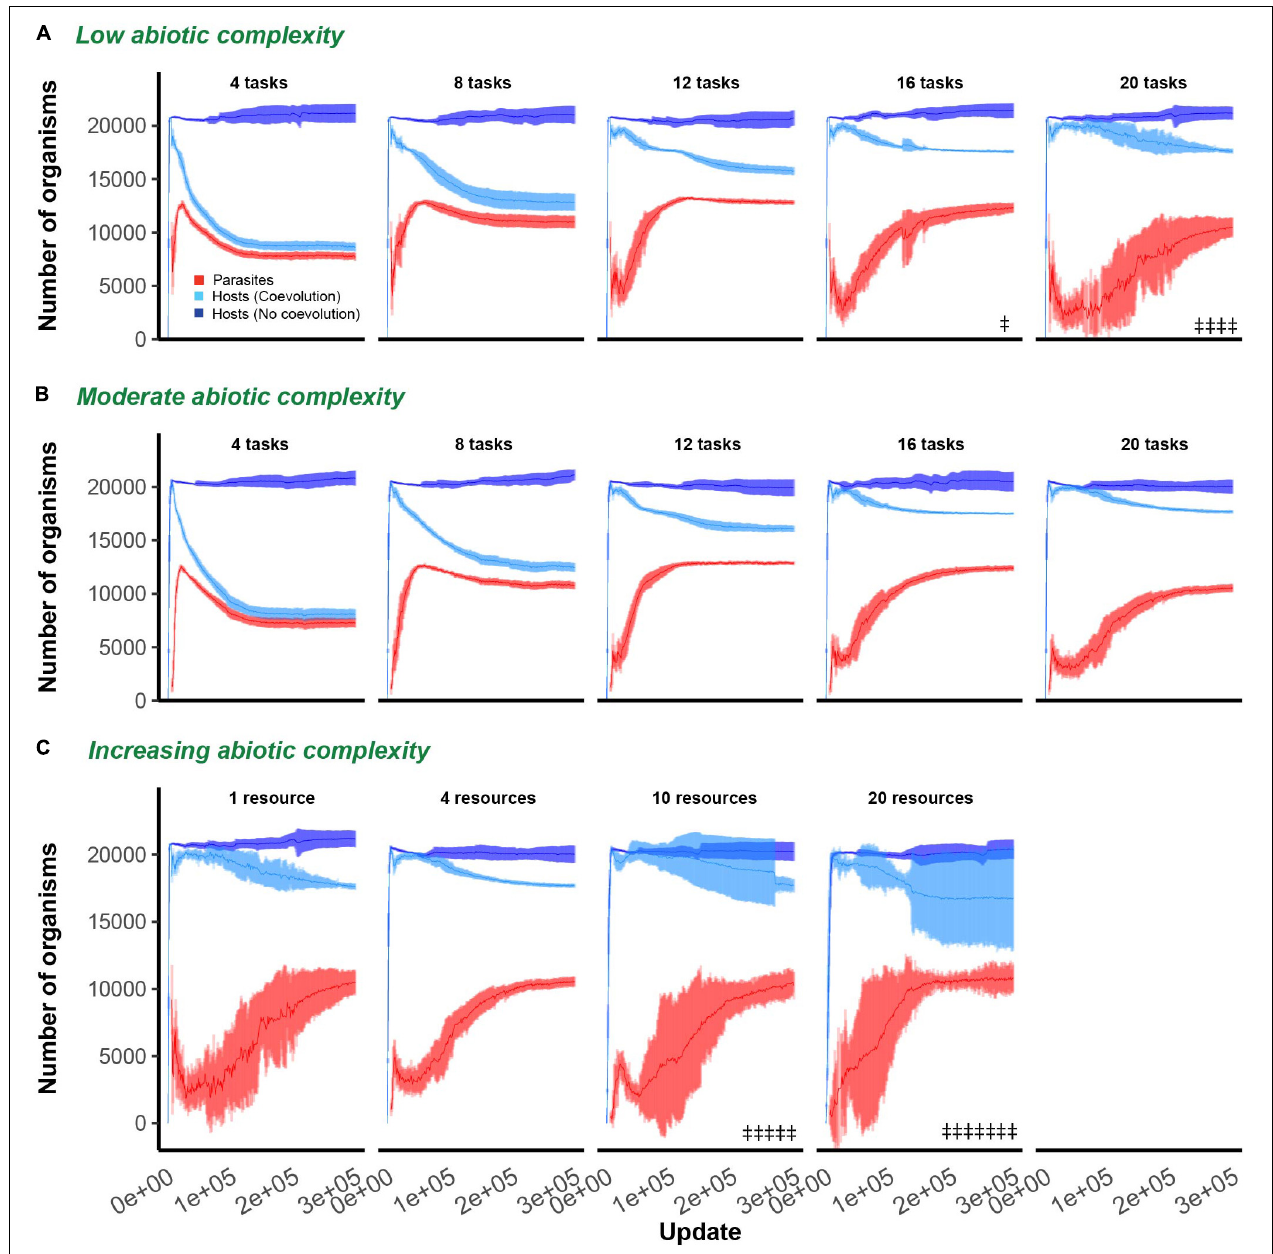
FIGURE 2 | Host and parasite dynamics through time. Mean and 95% confidence intervals are shown for hosts (non-coevolving in dark blue, coevolving in light blue) and parasites (red) through time. In all evolutionary experiments, hosts were allowed to evolve for 300,000 updates. In (A,B) , ecological complexity was held constant at either one or four resources, respectively, while varying the available phenotypic space (4, 8, 12, 16, or 20 tasks in each subplot). In (C) , the available phenotypic space was held constant at 20 tasks, and dynamics are shown for increasing levels of abiotic complexity (4, 8, 10, or 20 resources in each subplot). Only data from those host populations in which parasites did not go extinct are shown. Double headed daggers indicate runs in which parasites went